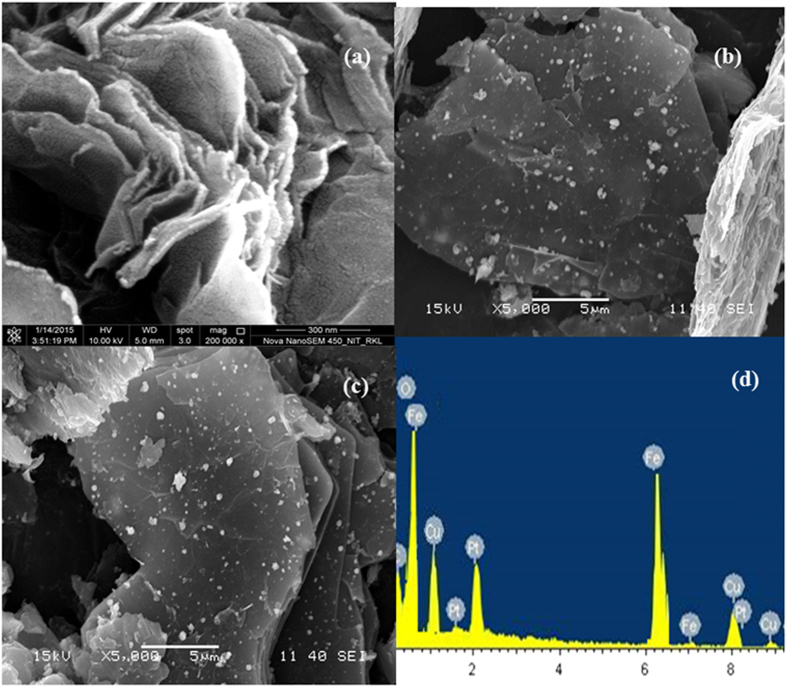
FE-SEM images of (a) GO and (b,c) GO-CuFe2O4 nanocomposite, (d) EDX of GO-CuFe2O4 nanocomposite.